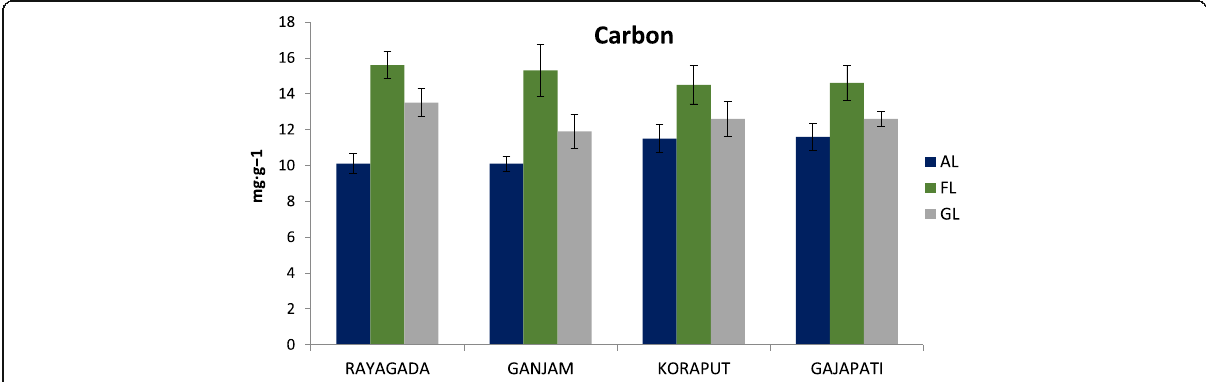
Fig. 2 Organic carbon percentage with means under different habitat conditions across four districts